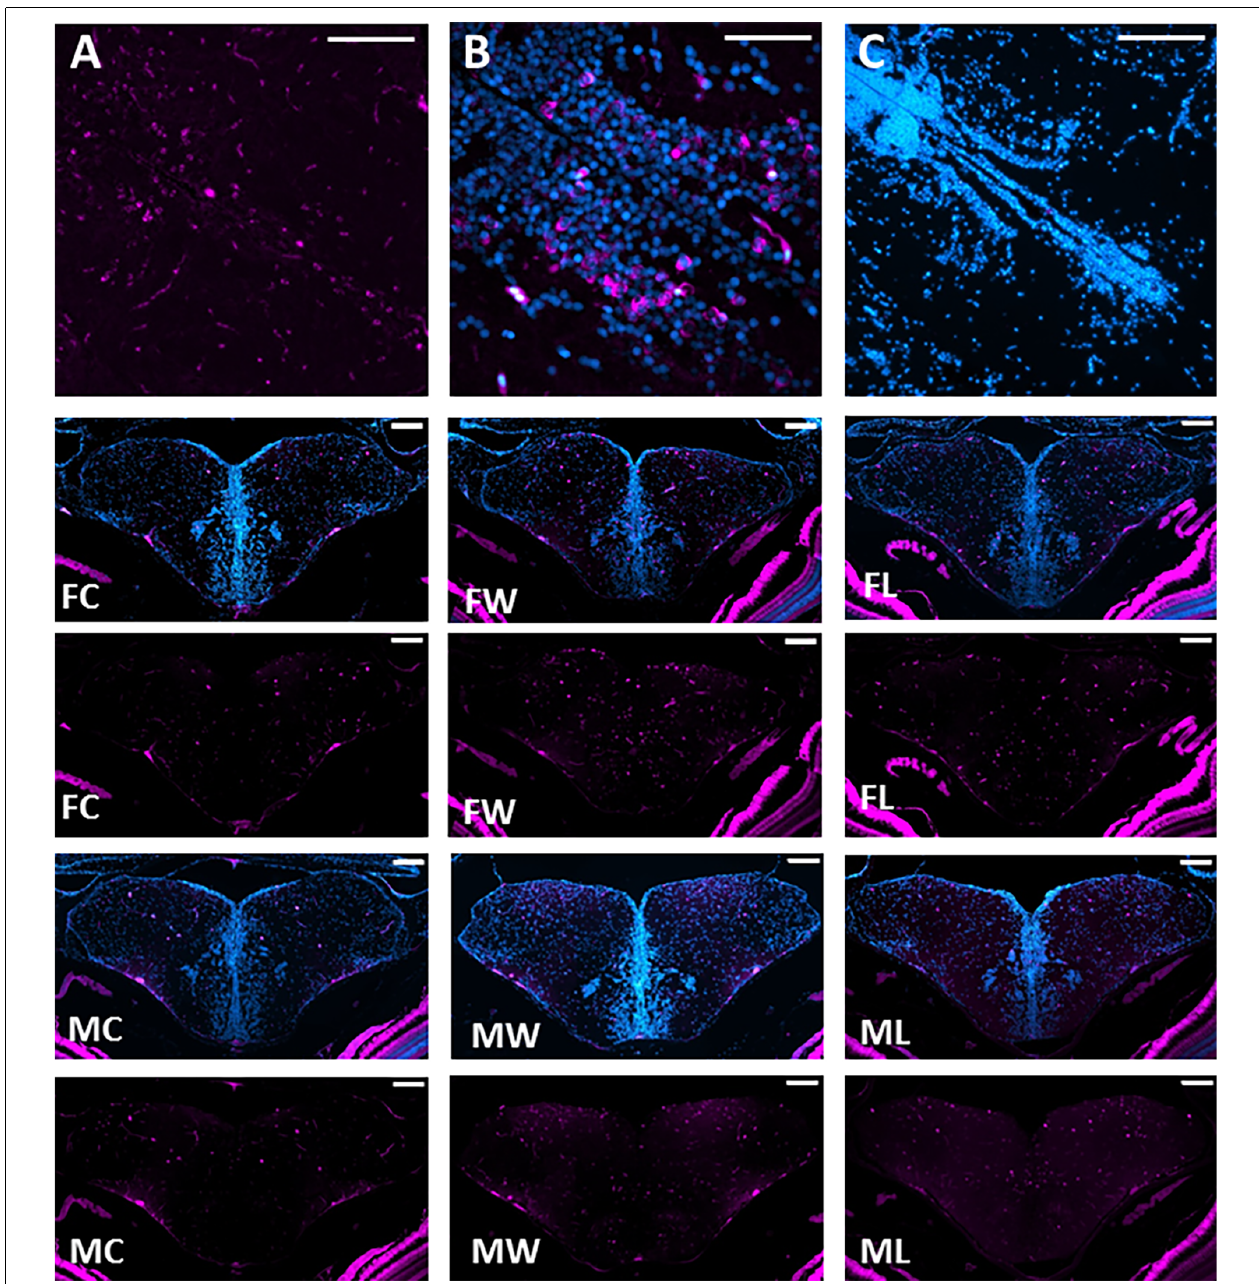
FIGURE 2 | Neuronal activation throughout the brain Social Decision Making Network. (A) pS6 immunopositive staining with cytoplasmatic location is indicated in magenta. (B) Sections were co-stained with DAPI, indicated in cyan. (C) Negative control for pS6 and DAPI immunofluorescence. Representative photomicrographs of double DAPI (blue) and pS6 (magenta) and only pS6 staining (magenta) in Dm, Dl, Vc, Vd, and Vv of female controls (FC), female winners (FW), female losers (FL), male controls (MC), male winners (MW), and male losers (ML). Scale bars represent 100